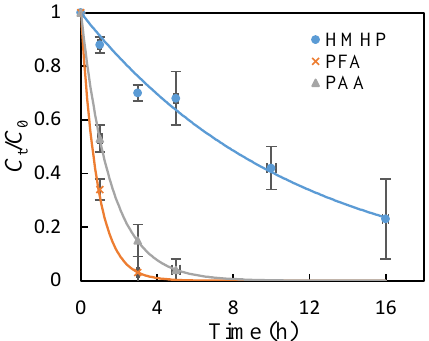
Figure 1. Evolution of total peroxides and H 2 O 2 contents in SOA produced under dry ( < 0.5%RH) and wet (60%RH) conditions at 298K. Circles and squares represent total peroxides and H 2 O 2 con- tents in SOA, respectively; and solid lines and dashed lines repre- sent that obtained under dry and wet conditions, respectively. The data represent the mean ± SD of three observations.